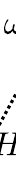
Figure 10: State spaces Ω that contain more than one state have capacity at least N = 2 (for argumentation see main text). The plane here is the affine space { x ∈ A | u ( x ) = 1 } A